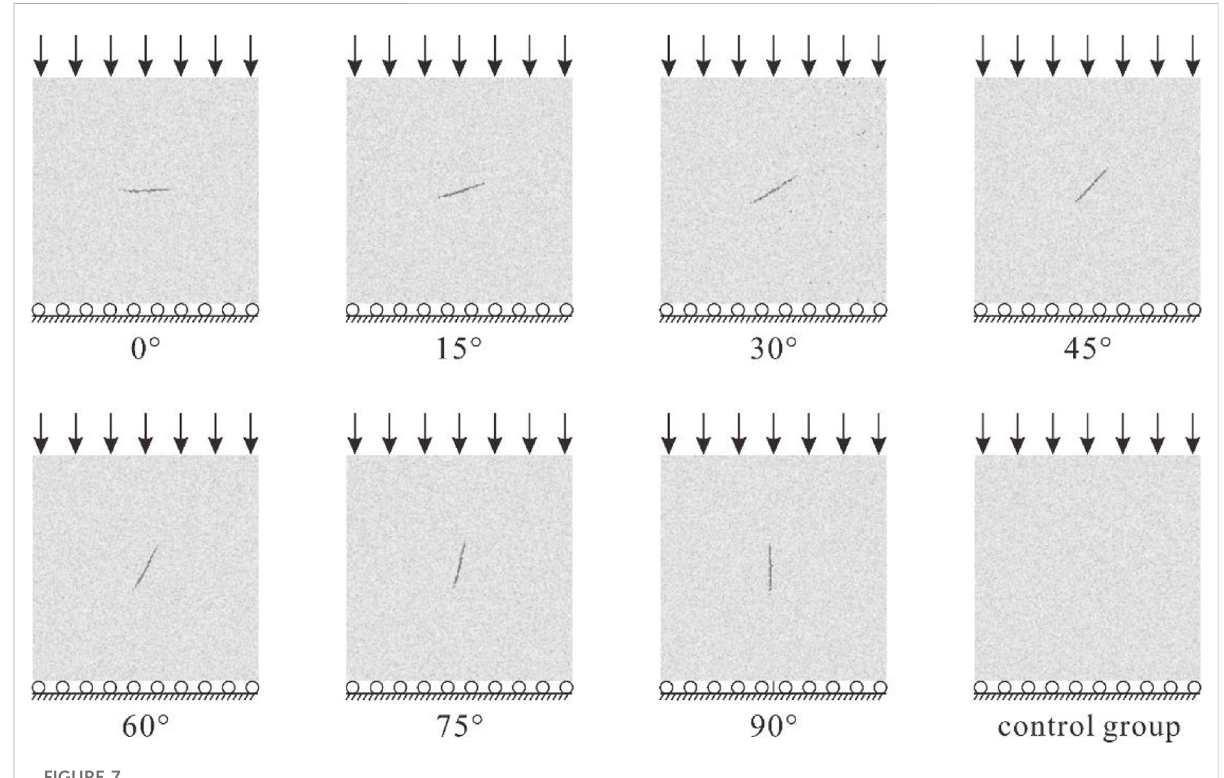
FIGURE 7 Schematic diagram of model loading.